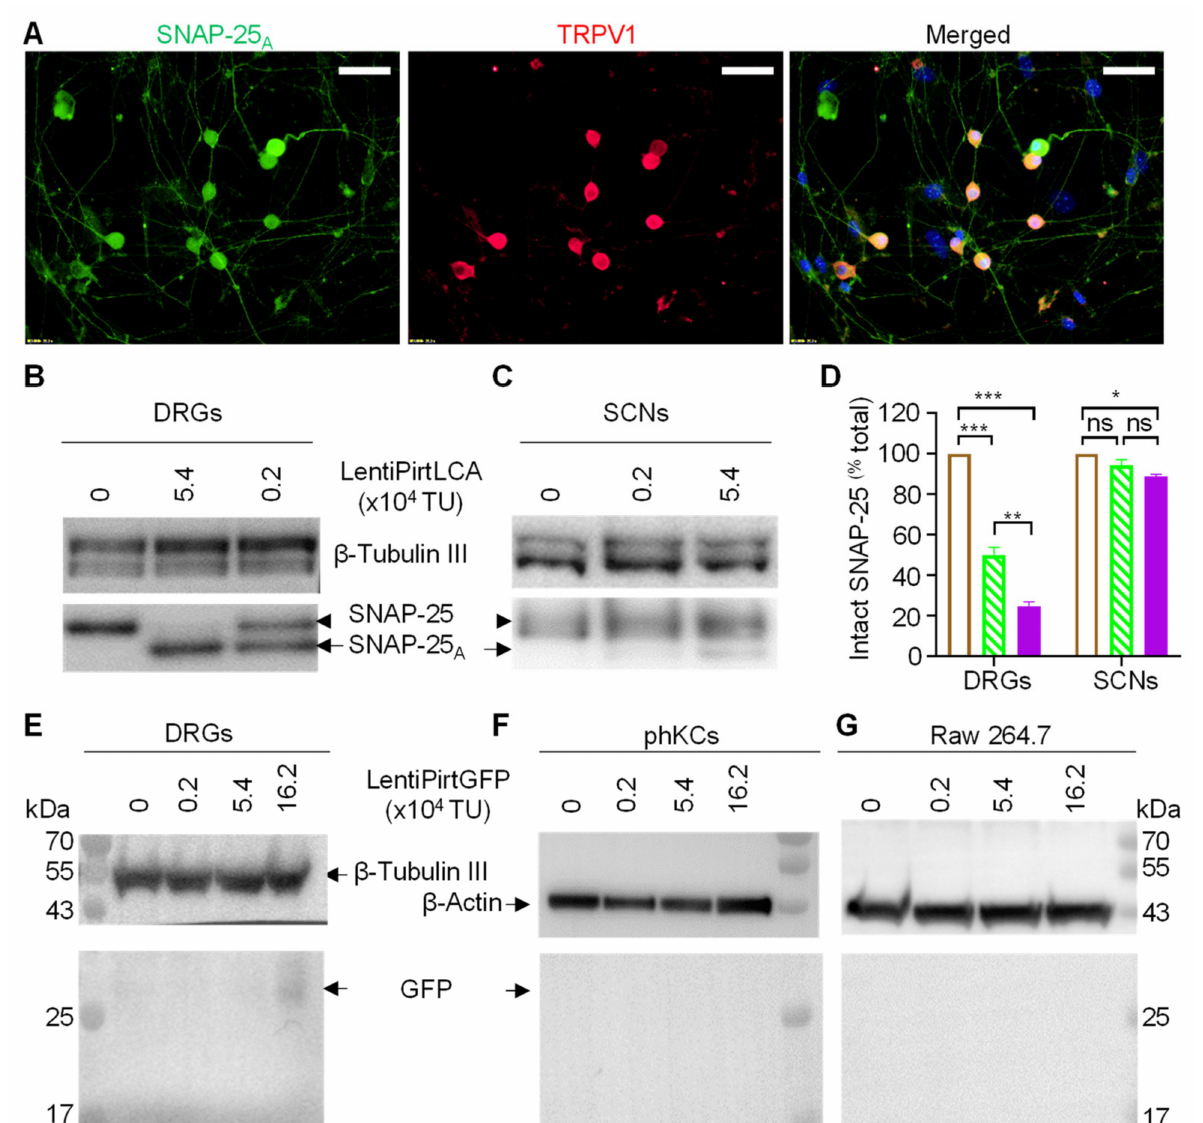
Figure 2. Pirt promoter drove exogenous gene expression selectively in sensory neurons. ( A ) Cultured mouse DRGs were incubated with 5.4 × 10 4 TU/well for 5 days before performing double immunofluorescent staining with antibodies for the LCA cleaved SNAP-25 A (green) and TRPV1 (red). The nuclei were stained blue with 4 (cid:48) , 6-Diamidino-2-phenylindole dihydrochloride. Bars, 50 µ m. Cultured mouse DRGs ( B ) and spinal cord neurons (SCNs) ( C ) were infected by lentiPirtLCA with the indicated doses for 5 days before probing the SNAP-25 cleavage by the expressed LCA. Intact SNAP-25 and LCA cleaved form were probed by Western blotting with an antibody recognizing both intact and cleaved forms. ( D ) Quantified data derived from densitometric scanning of 3 replicate gels. Empty bars, virus free; hatched bars, 0.2 × 10 4 TU; filled bars, 5.4 × 10 4 TU. Data presented are mean ± SEM, from three independent cultures. One-way ANOVA with Bonferroni’s multiple comparison test demonstrated significant differences between the groups in DRGs: virus free vs. 0.2 × 10 4 TU p = 0.00003; virus free vs. 5.4 × 10 4 TU p < 0.00001; 0.2 × 10 4 TU vs. 5.4 × 10 4 TU p = 0.00119. In SCNs: virus free vs. 5.4 × 10 4 TU p = 0.01327. * p < 0.05; ** p < 0.01; *** p < 0.001, p > 0.05. Mouse DRGs ( E ), primary human keratinocytes (phKCs) ( F ) and Raw 264.7 cells ( G ) were infected with lentiPirtGFP for 5 days before probing the expression of GFP protein by Western blotting. β -tubulin III and β -actin proteins were probed as loading